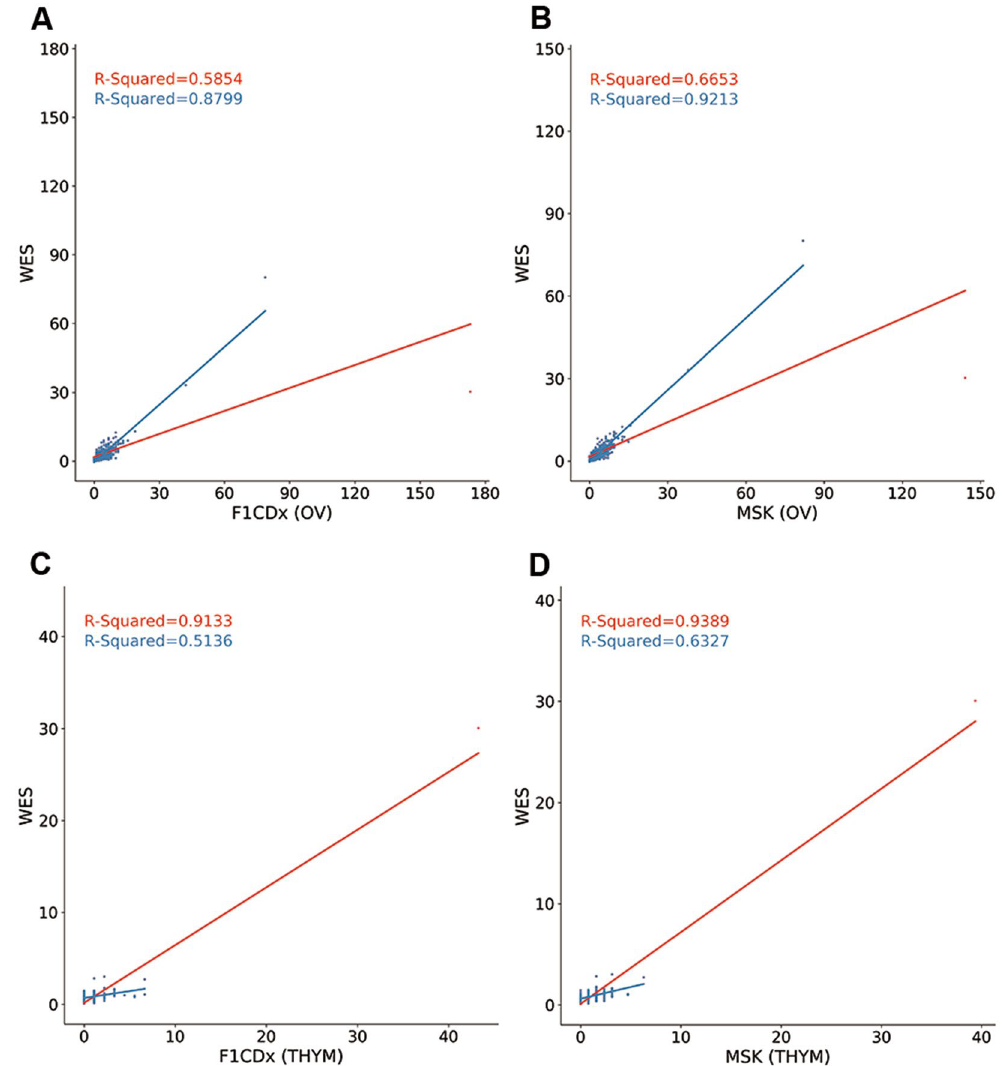
Figure 3. Linear fit of panel-based TMB estimated by the F1CDx ( A , C ) and MSK ( B , D ) against WES-based TMB in cancer type OV dataset ( A , B ) and THYM dataset ( C , D ). The poor R-squared value in the cancer type OV dataset is due to the highly estimated bias of one patient (TCGA-13-0889, red dot in A , B ) with very high TMB relative to other patients in the dataset, whereas the high R-squared value in cancer type THYM dataset is because the estimated bias of the patient (TCGA-ZB-A966, red dot in C , D ) with very high TMB relative to other patients in the dataset is